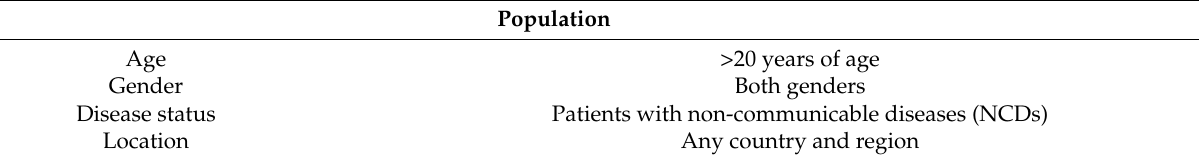
Table 1. Population, intervention, control, outcome, and time